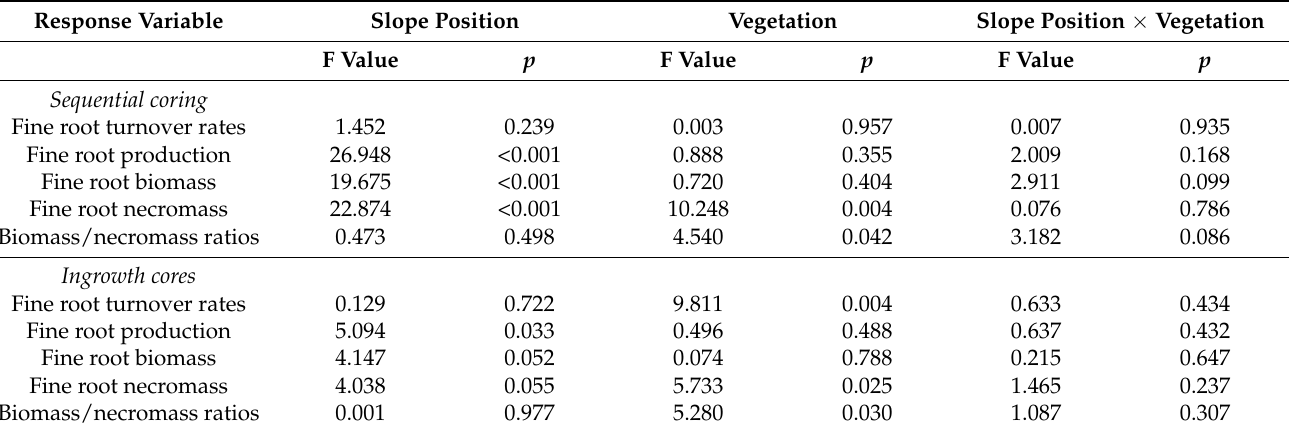
Figure 2. Fine root turnover rates, production, biomass, necromass, and biomass/necromass ratios in different slope positions and vegetations of a karst ecosystem. # Lowercase letters indicate significant differences ( p < 0.05) among the three slope positions; capital letters indicate significant differences ( p < 0.05) between the two vegetation types. ( a , c , e , g , i ) were the patterns of fine root turnover rates, production, biomass, necromass, and biomass/necromass ratios measured by sequential coring, respectively; ( b , d , f , h , j ) were the patterns of fine root turnover rates, production, biomass, necromass, and biomass/necromass ratios measured by ingrowth cores, respectively. Fine root turnover parameters responded to slope position and vegetation in a karst